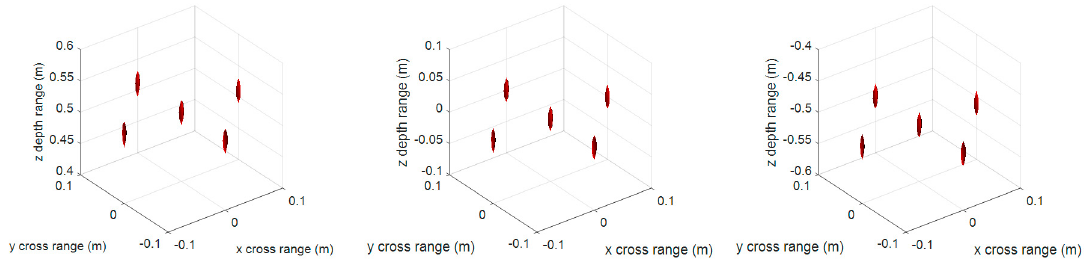
Figure 3. 3-D imaging results of the conventional range migration algorithm (RMA) with compensation distance 0 ( left ), 0.51 m ( middle ), and 1.02 m ( right